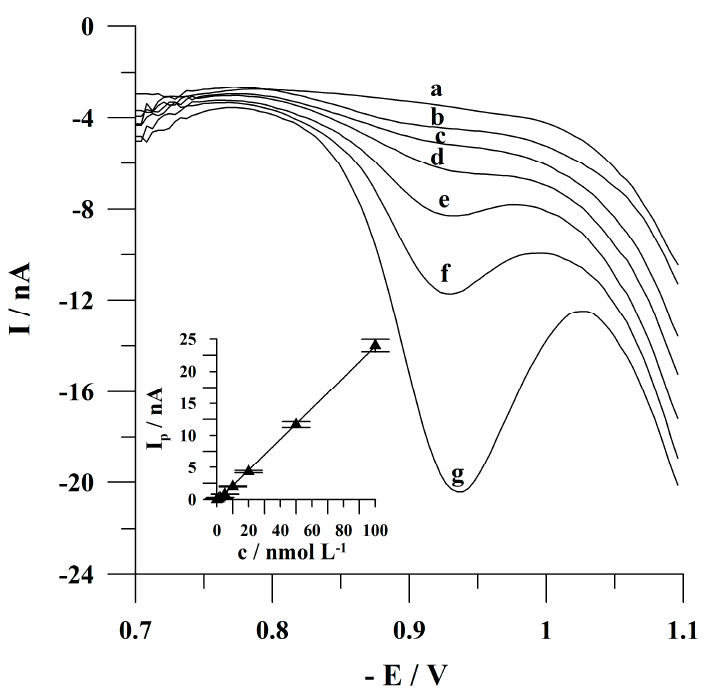
Figure 8. Square wave voltammograms registered for the lowest U(VI) concentrations: (a) blank; (b) 1 × 10 − 9 ; (c) 2 × 10 − 9 ; (d) 5 × 10 − 9 ; (e) 1 × 10 − 8 ; (f) 2 × 10 − 8 ; (g) 5 × 10 − 8 mol L − 1 . Accumulation conditions: − 0.7 V, 120 s. Inset: linear calibration graph of U(VI) determination at 120 s of accumulation. The error bars refer to the standard deviation (n = 3).